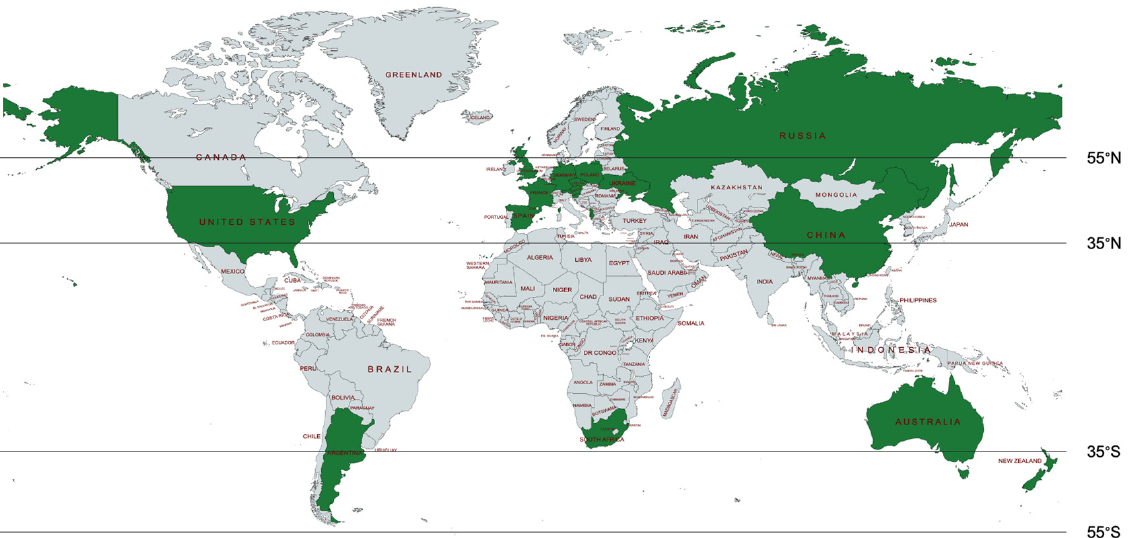
Figure 1. Main producing countries and hop production areas in the world (in green), with emphasis on those located between latitudes 35° and 55° N and S.